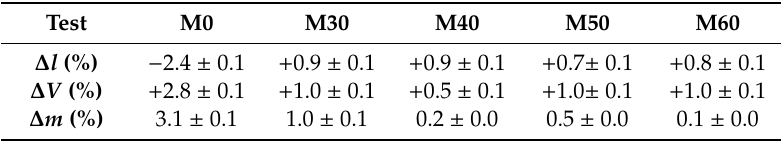
Table 6. Results of linear dimension changes, geometrical volume changes and mass loss of obtained